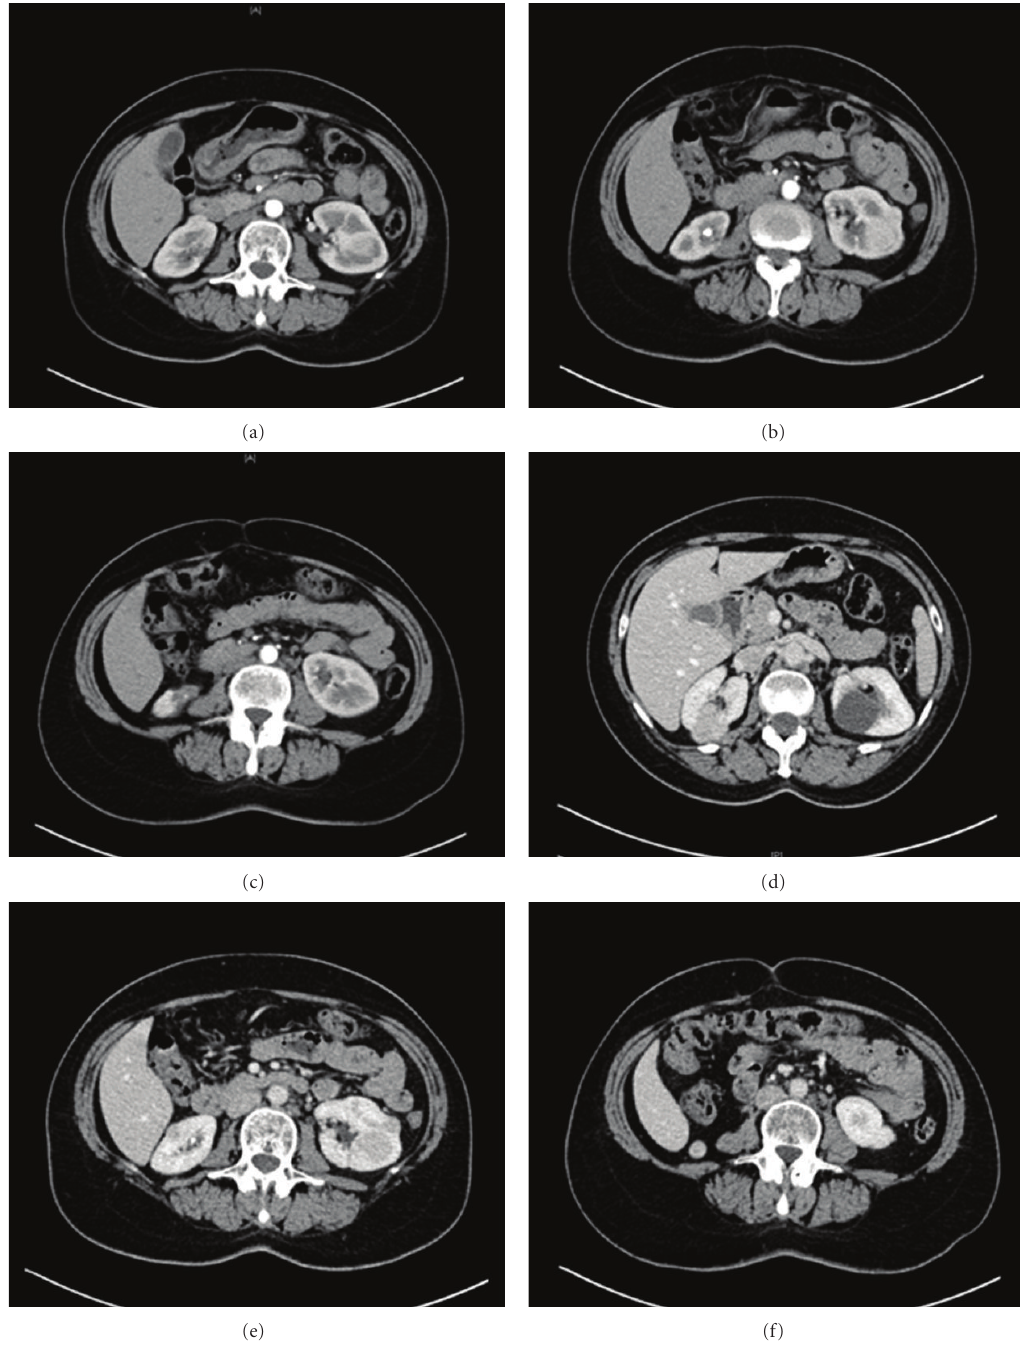
Figure 1: Preoperative contrasted CT scans of the patient, showing multiple bilateral kidney tumors, with diameters ranging between 1 and 5cm. Radiologically, most of the tumors have malignant characteristics due to their hypervascularity and radiopaque